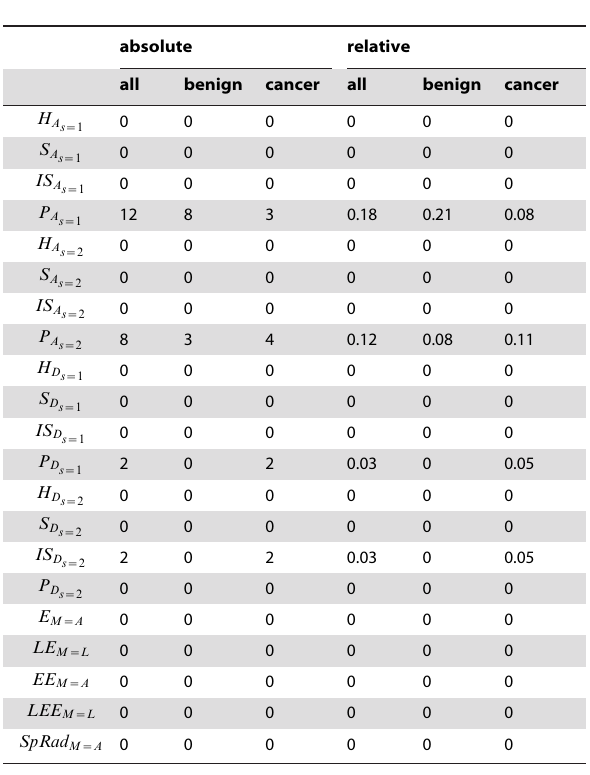
Table 7. ndV-values for the structural biomarkers (eigenvalue and entropy-based measures) for prostate cancer networks and the corresponding subgroups (benign/cancer) for